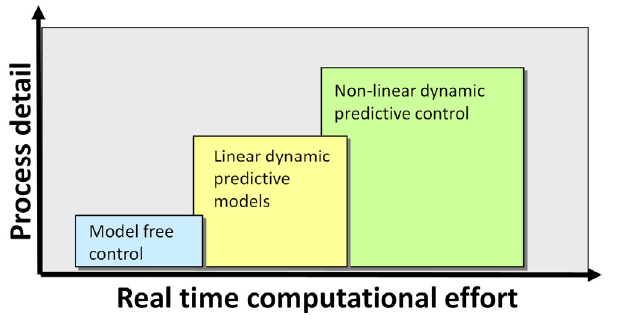
Figure 6. Control approaches with respect to process detail and real time computational